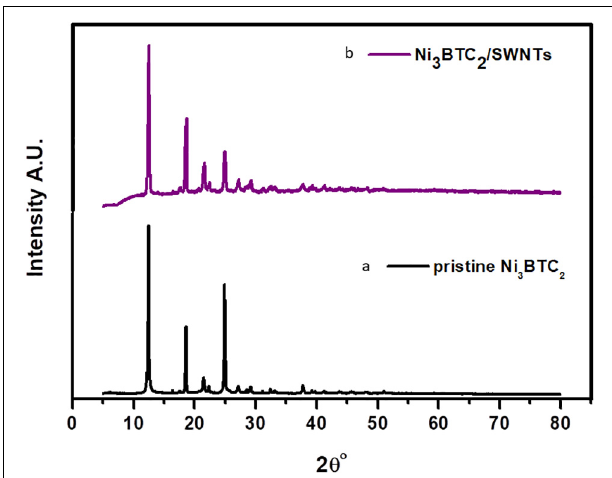
FIGURE 3 | XRD patterns (2 θ ◦ range 24 ◦ to 27 ◦ ), (a) pristine Ni 3 BTC 2 and (b) composite of Ni 3 BTC 2 /OH-SWNTs.